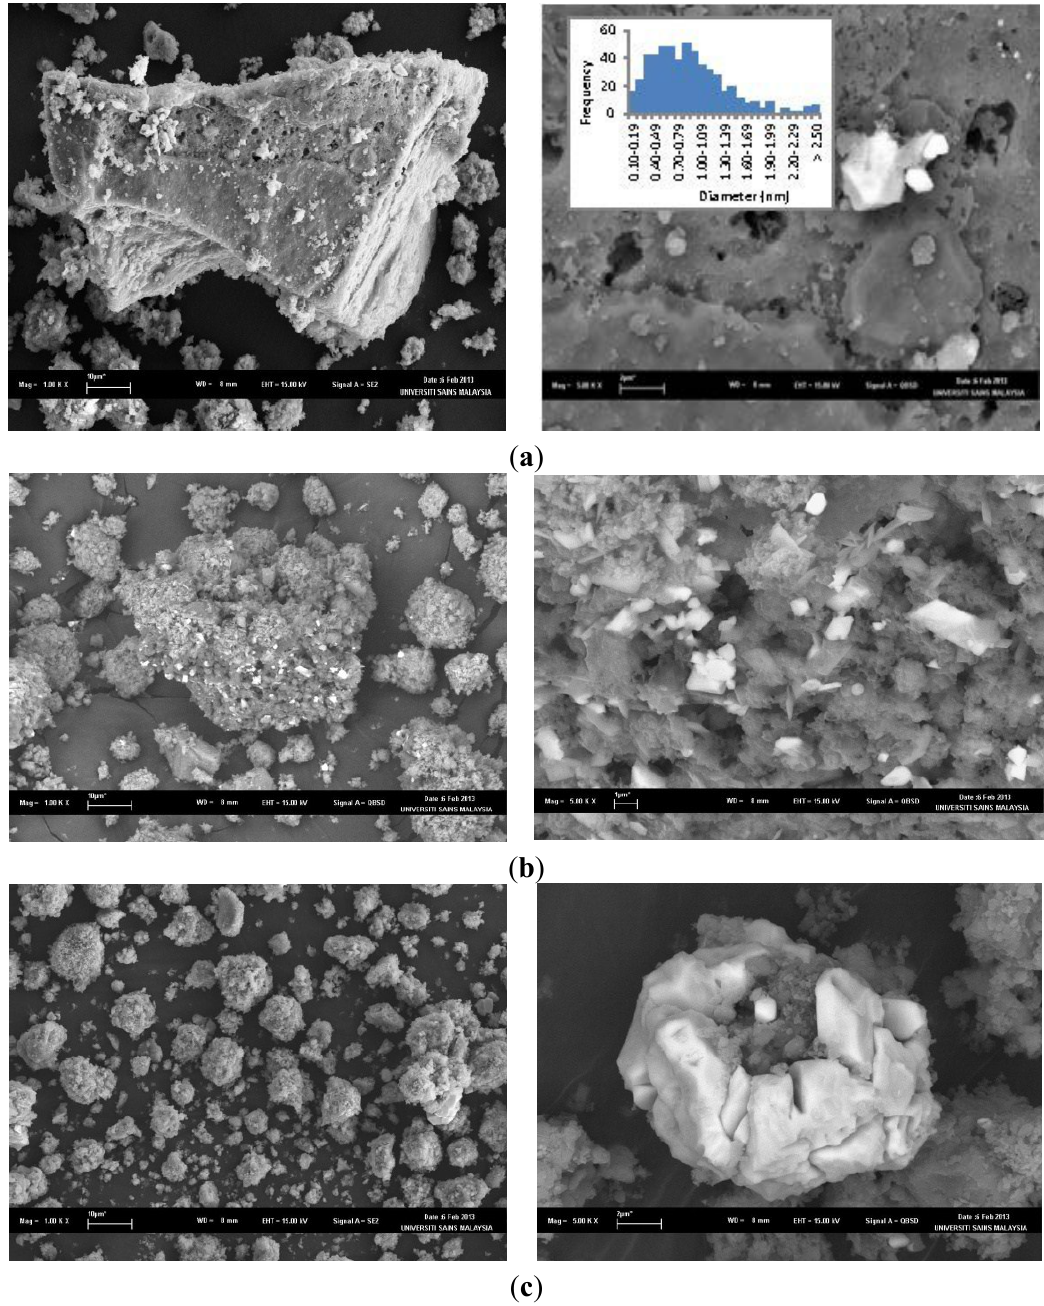
Figure 2. SEM images of Cu particles deposited on PS powder with a metal loading